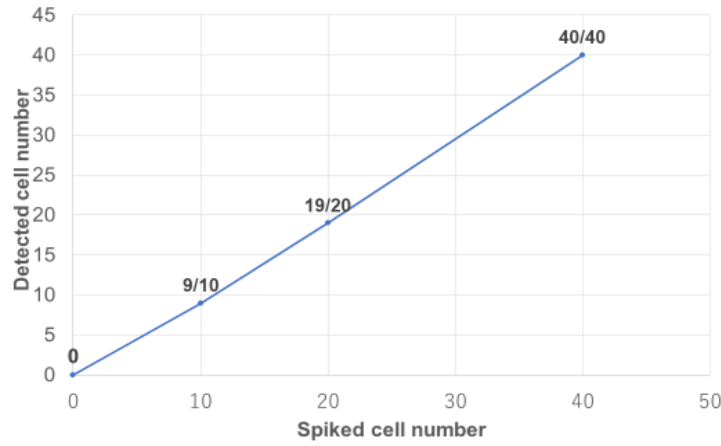
Figure 4. RCC cells concentration using CelSee ® and spiked RCC cells counting using On-chip Sort ® with anti-G250 antibody. Recovery of known numbers of spiked VMRC-RCW cells whole blood. VMRC-RCW cells (1, 10, 20, 40 cells) were spiked into 4 ml of blood from healthy volunteers. The number of spiked VMRC-RCW cells vs. observed number of recovered cells is plotted.